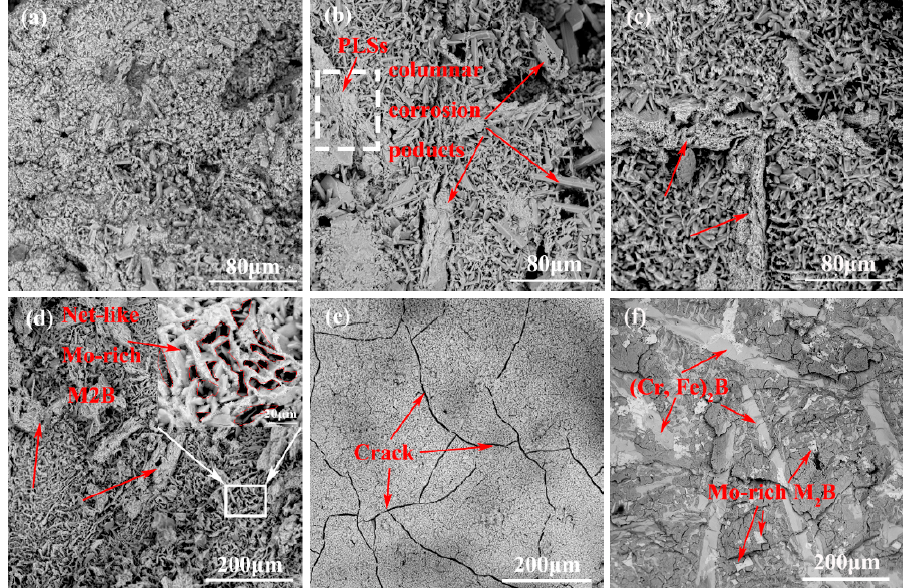
Figure 12. Morphologies of the corroded surface after removing the residual aluminum with a 10% NaOH solution: ( a ) M1; ( b ) M2; ( c ) M3; ( d ) M4; ( e ) H13, and the morphology after removing the IMC layer of M4 ( f ). All the samples were immersed in molten aluminum for 8 h at 750 °C.